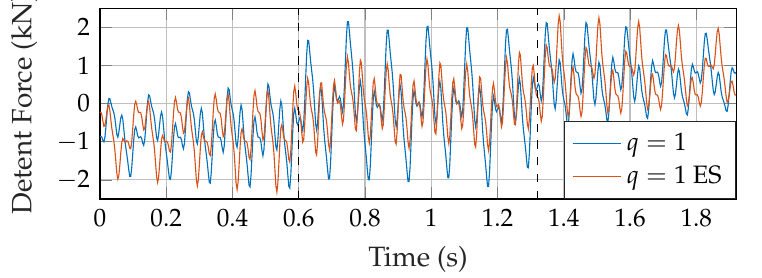
Figure 11. Detent forces for q = 1 with extended stator (ES). Full active stator area is from t = 0.6 s to t = 1.32 s, indicated by the dashed vertical lines.